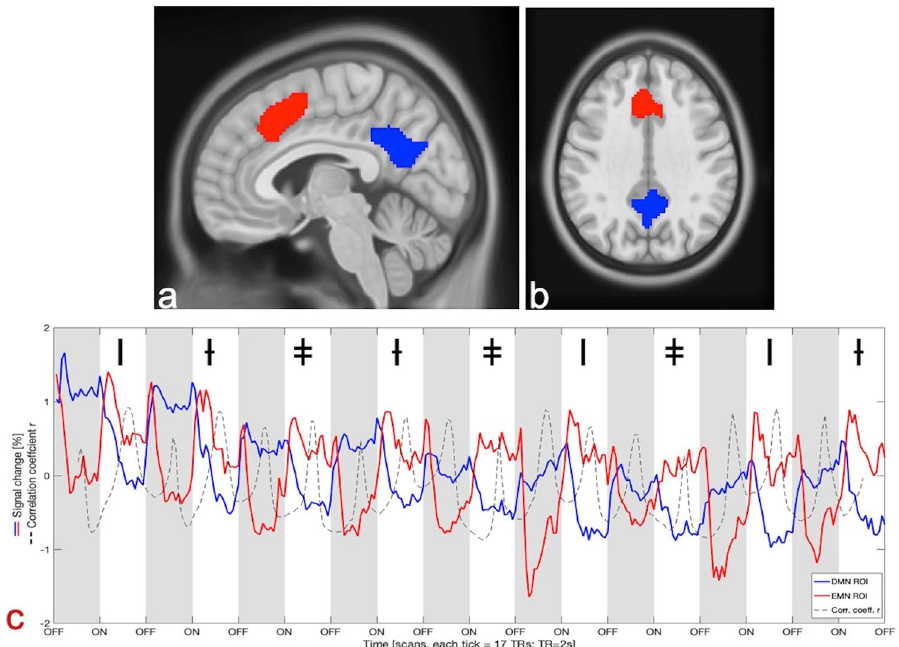
Figure 3. Sagittal ( a ) and axial ( b ) views of the ROIs shown on the MNI-T1 template. The DMN ROI is shown in blue and the EMN ROI in red. The ROIs were used for the time-series extraction shown in ( c ): The tasks alternated randomly between mental rotation (marked with the symbol I), working memory (marked with the symbol Ɨ ) and mental arithmetic (marked with the symbol ǂ ). Signal change is shown as percentage of total signal change and keeping in line with the colour coding for the ROIs as in panels ( a ) and ( b ). Onsets and offsets of the task and rest periods are shown on the x-axis as ON and OFF respectively with OFF-blocks also being marked in grey. The black intermittent line in panel ( c ) shows the Pearson correlation coefficients continuously calculated on the mean of a 17 s sliding-window through the whole